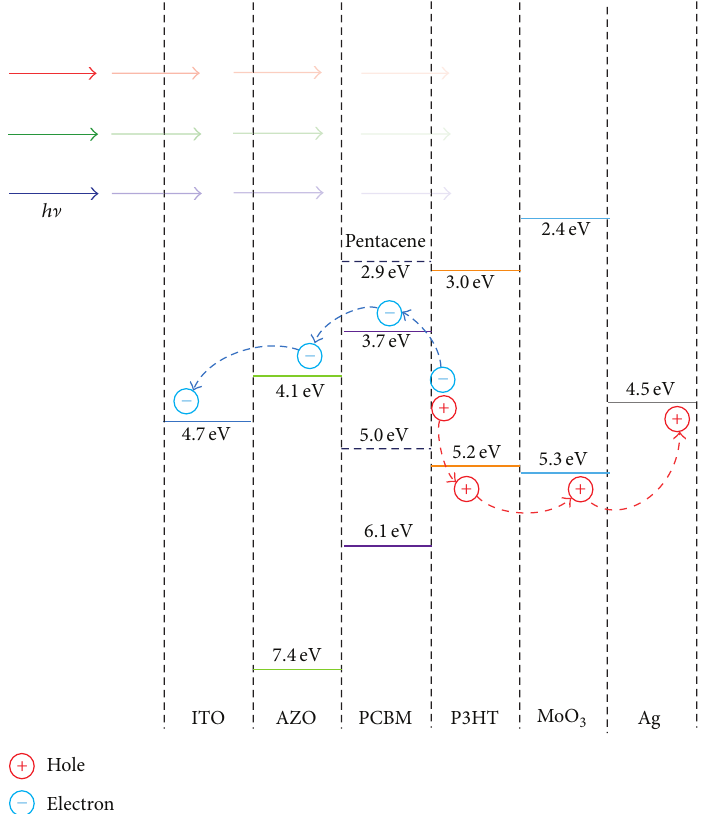
Figure 3: Schematic diagram of energy levels for inverted PSCs with pentacene-doped absorption layer.